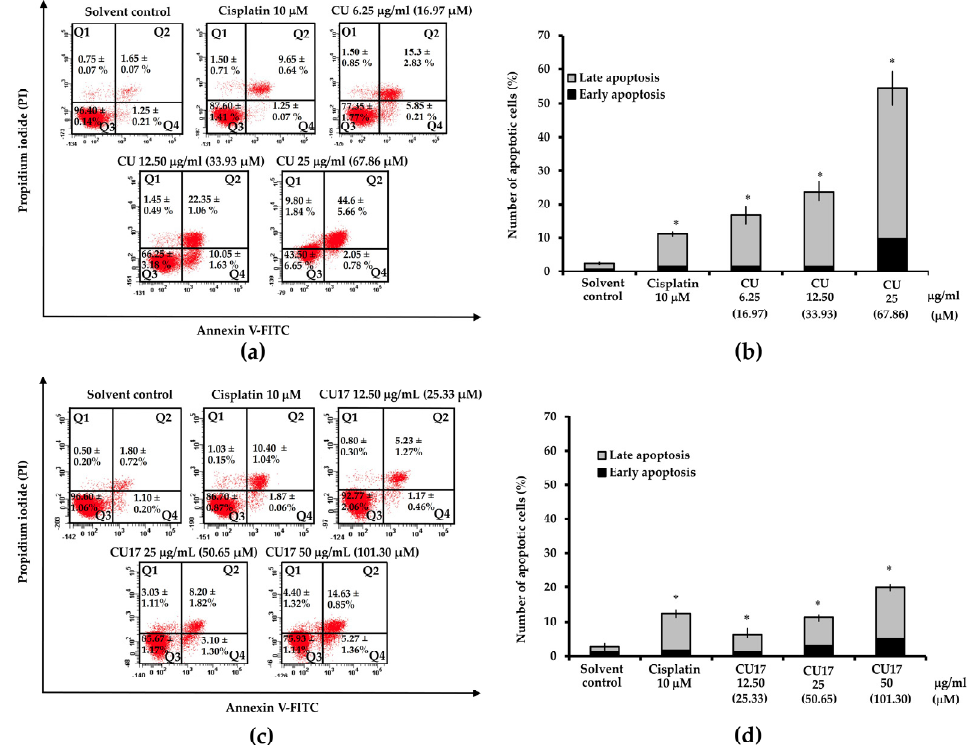
Figure 7. Effect of CU and CU17 on apoptosis induction in A549 cells for 24 h exposure. ( a , c ) The dot plots present the analysis of apoptosis induction on A549 cells after CU or CU17 treatment. ( b , d ) Bar graphs of the mean from three independent experiments displayed the percentages of apoptotic cells. A549 cells were treated with DMSO: ethanol (1:1, v / v ) and cisplatin (10 µM) as negative and positive controls, respectively. * p < 0.05 indicates a significant difference between the treatment and solvent control.